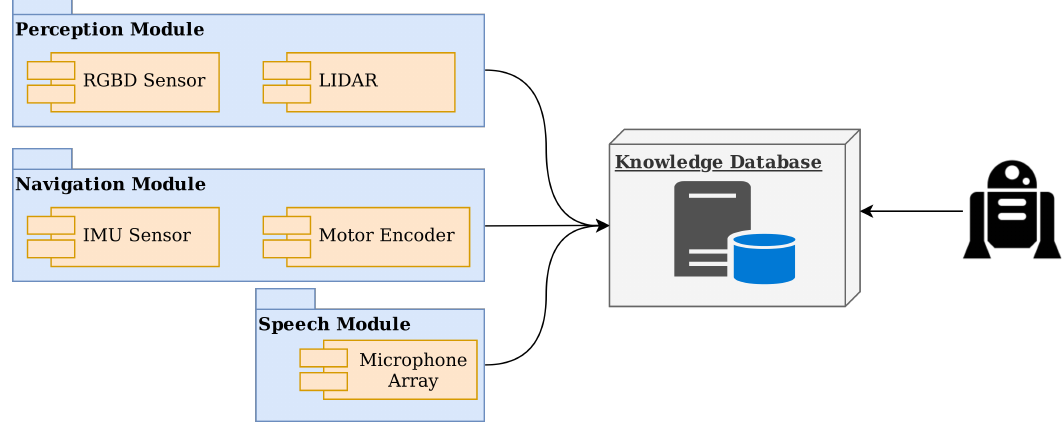
Figure 4. Architecture used by most robot